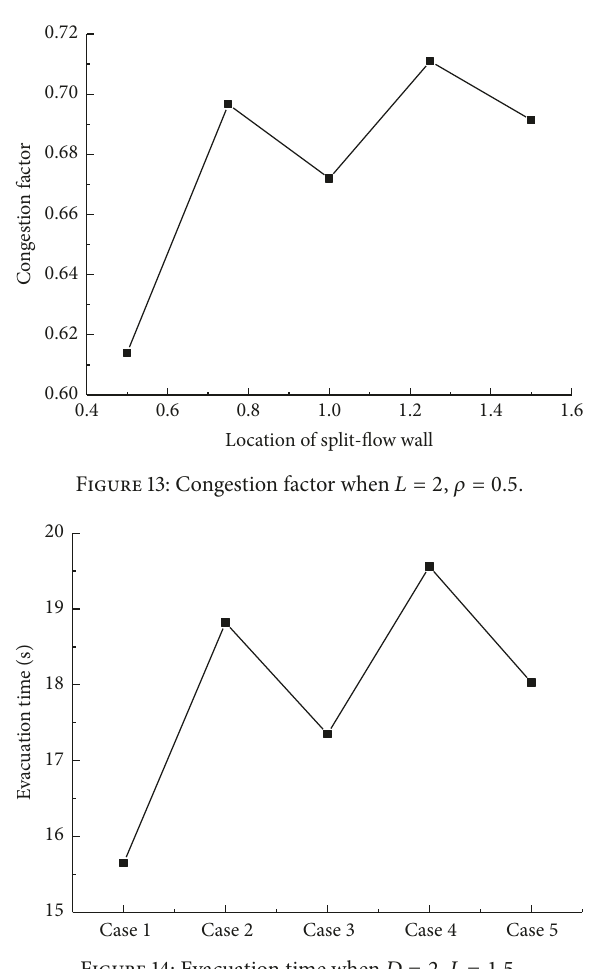
Figure 14: Evacuation time when 𝐷 = 2 , 𝐿 = 1.5 .